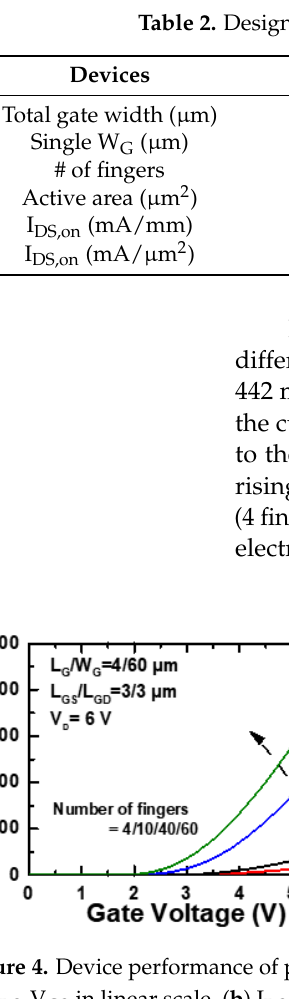
Table 2. Design parameters for W G = 60 μ m devices with different number of fingers.